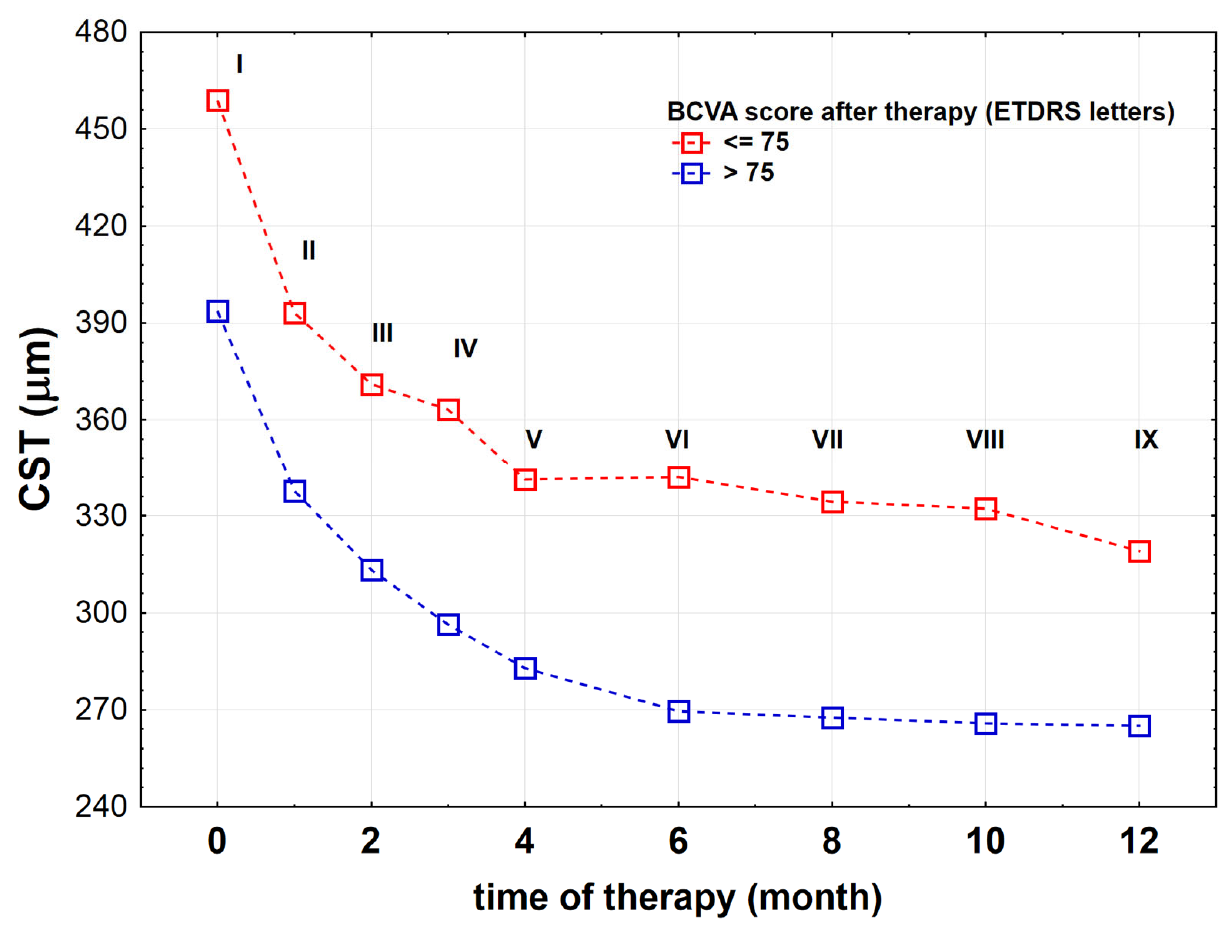
Figure 5. The macular CST (central subfield thickness) in the BCVA ≤ 75 group ( n = 41) and the BCVA >75 group ( n = 57) of patients with diabetic macular edema (DME) during subsequent intravitreal bevacizumab injections.